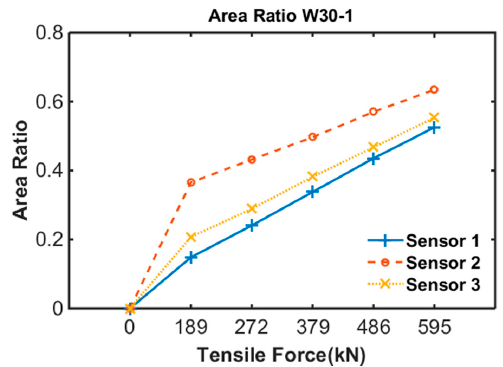
Figure 11 . Area ratio of specimen 1 . Figure 11. Area ratio of specimen 1.